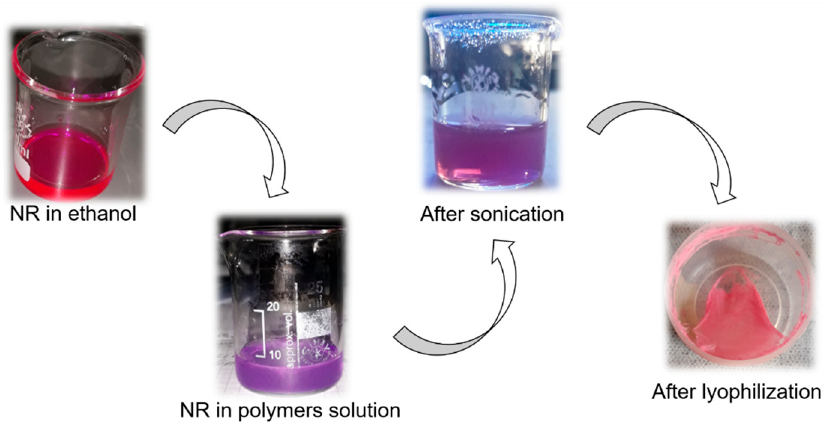
Figure 8. Behavior of NR in different media of interaction: NR in ethanol: fuchsia color. NR in aqueous solution of the polymers: purple color. After sonication: light purple color. After lyophilization process: light pink color.